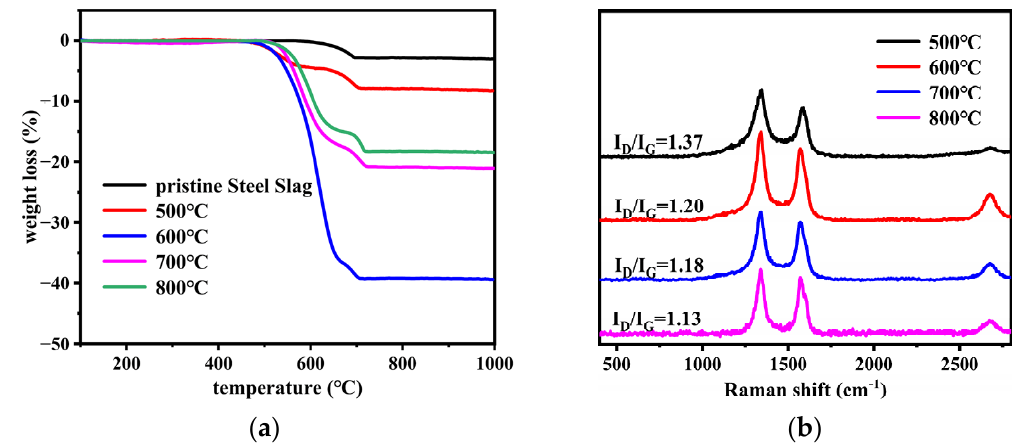
Figure 6. The TGA ( a ) and the Raman spectra ( b ) of SS@CNTs synthesized at various temperatures. Table 4. The corresponding parameters of TGA of the SS@CNTs synthesized at various tempera- tures.